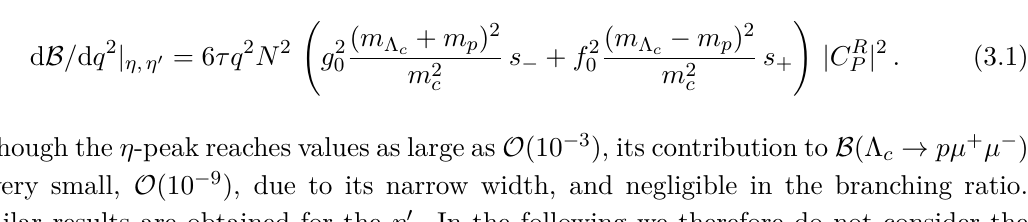
. The central line in the c